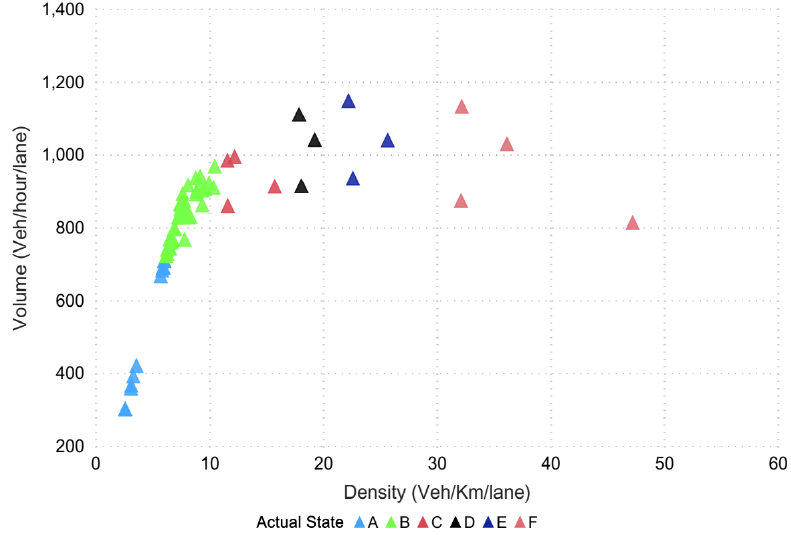
Figure 7. The actual density–flow via VISSIM.